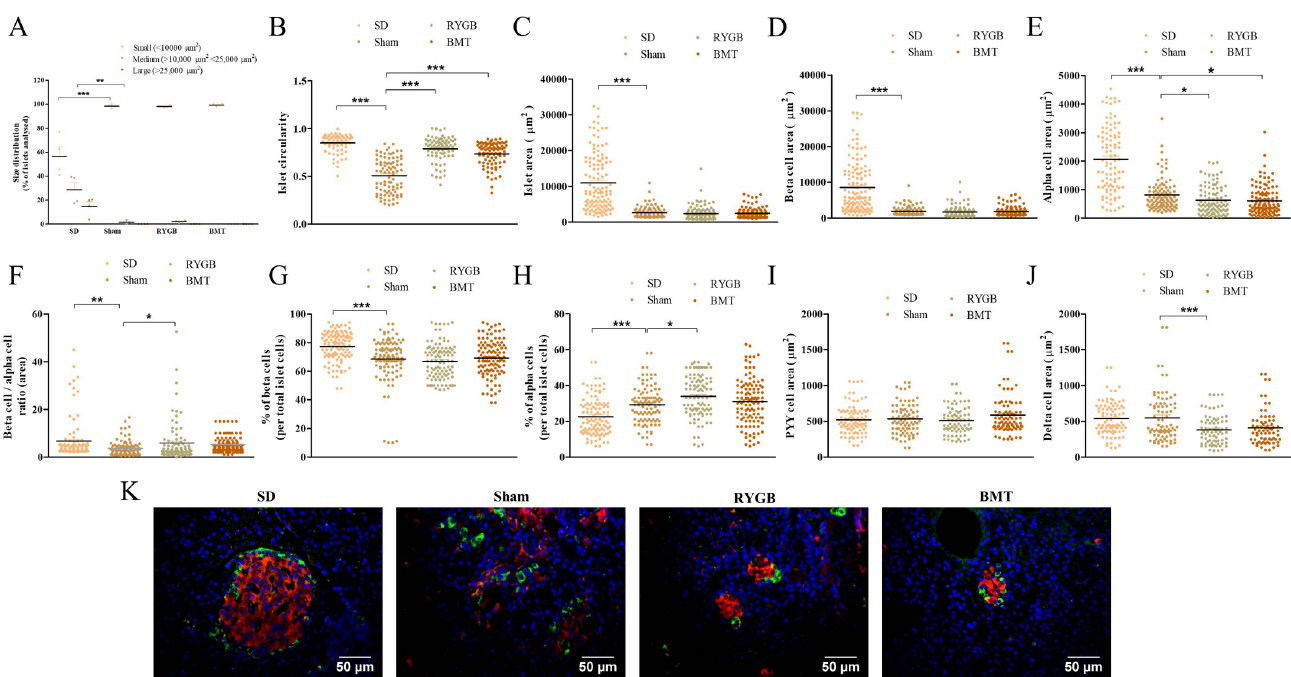
Fig 7. Effects of RYGB, BMT and sham surgery on islet morphology and architecture 8 weeks post-experimental intervention in ZDSD rats. (A) Size distribution (% of islets analyzed), (B) islet circularity–reports degree of roundness where 1.0 corresponds to a perfect circle, (C) islet area, (D) beta- cell area, (E) alpha-cell area, (F) beta- cell / alpha -cell ratio (area), (G) percentage of beta- cells (per total islet cells), (H) percentage of alpha-cells (per total islet cells), (I) PYY cell area and (J) delta-cell area, were determined using the ‘closed polygon’ and ‘multi-point’ tool in Olympus Cell ˆ F analysis software. Normal SD rats are included for comparison. (K) Representative images of islets showing insulin (red), glucagon (green). Nuclei are demonstrated using DAPI staining (blue). Values are mean ± SEM (n = 4) with statistical significance evaluated using one-way ANOVA. � p < 0.05, �� p < 0.01, ��� p < 0.001 compared to sham rats. Analyses carried out on 60–80 islets per